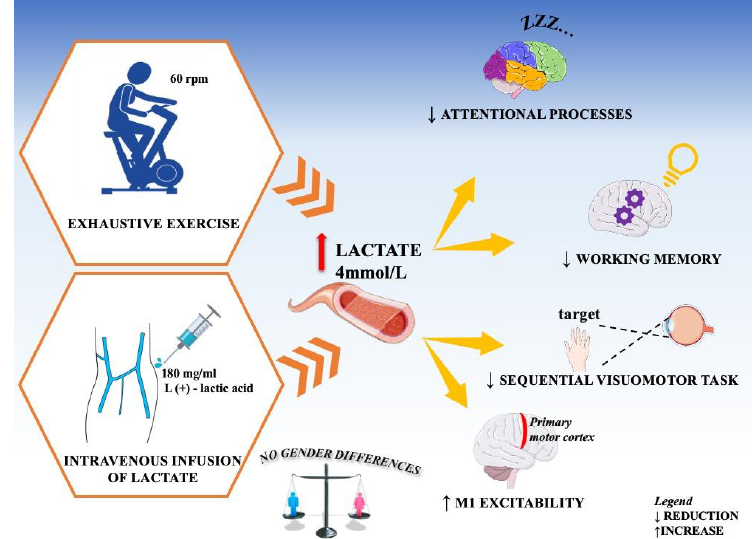
Figure 2. General diagram of the effects of lactic acid. When blood lactate levels exceed 4 mmol/L, this corresponds to the onset of blood lactate accumulation (OBLA). OBLA indicates the passage from aerobic exercise to anaerobic exercise.